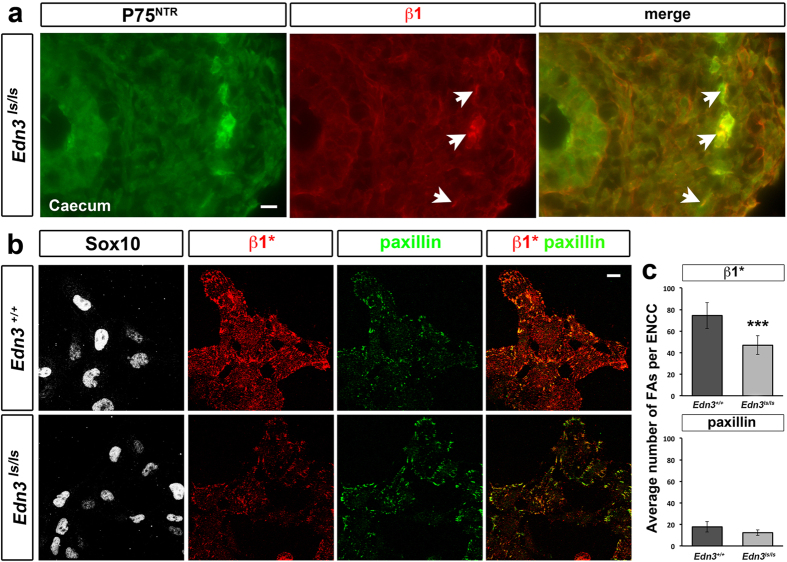
β1-integrin expression and quantification of FAs of Edn3ls/ls mutant ENCCs.(a) Immunostaining of caecum cryosections from E11.5 Edn3ls/ls mutants (n = 2) for ENCC marker (P75NTR) and pan-β1-integrin. Arrows point on β1-integrin staining of ENCCs. A Merged image for P75NTR (green) and β1-integrin (red) is shown in the right panel. (b) Activated β1-integrin (β1*) and paxillin immunostaining of ENCC progenitors (Sox10+) from E12.5 Edn3+/+ and Edn3ls/ls midgut explants cultured 24 h on FN. Scale bars = 10 μm. (c) Average number of β1*- and paxillin-positive FAs per ENCC for control and Edn3ls/ls mutants. The number of cells analysed was n = 836 and n = 711 over 5 Edn3+/+ and 5 Edn3ls/ls mutant midguts, respectively. Error bars indicate the SEM; ***p < 0.001.